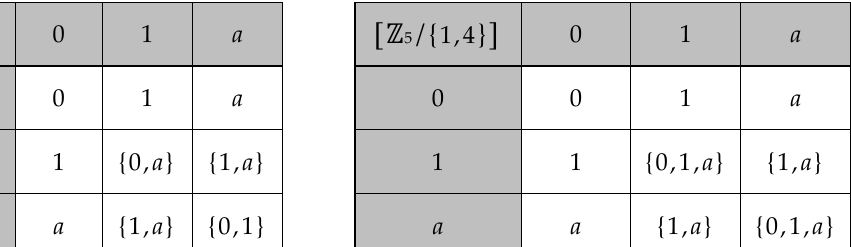
Table 3. The Cayley tables of the additive canonical hypergroups of the hyperfield ℤ 5 /{1,4} and its augmented hyperfield [ ℤ 5 / {1,4}] .